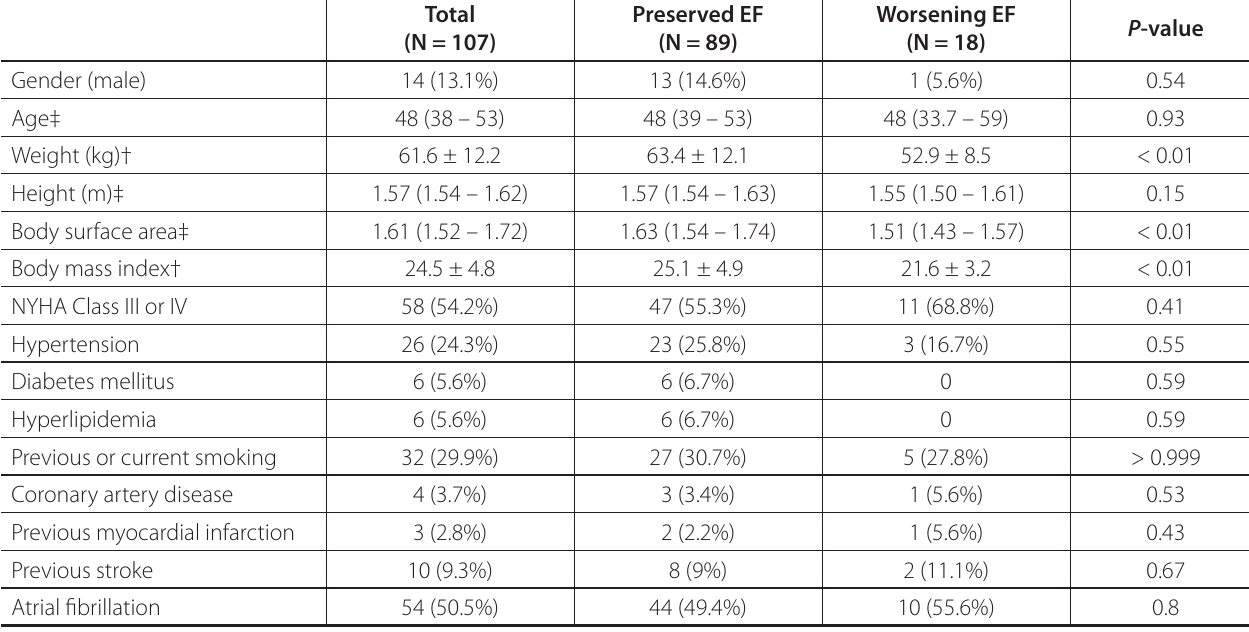
Table 1 . Distribution of patients’ preoperative